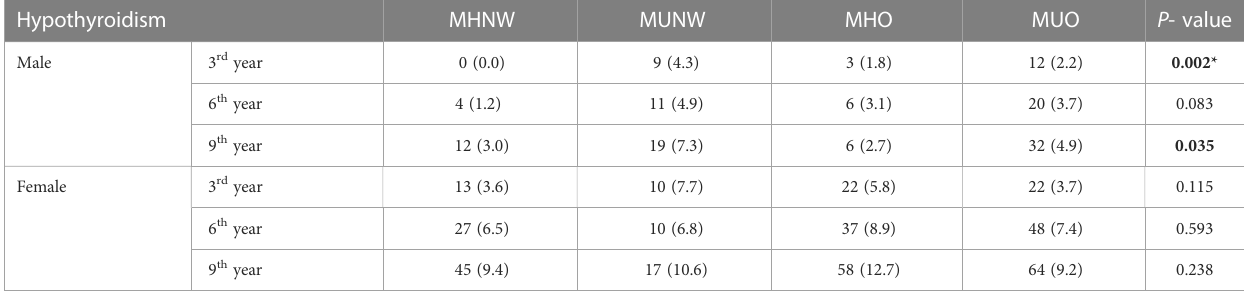
TABLE 2 Frequency (%) of hypothyroidism according to different metabolic phenotypes in male and female participants.